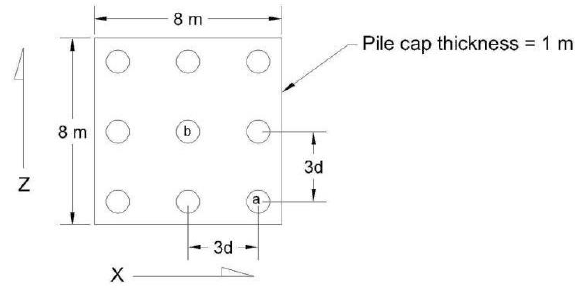
Figure 3: Piles cap dimension and Locations of piles in